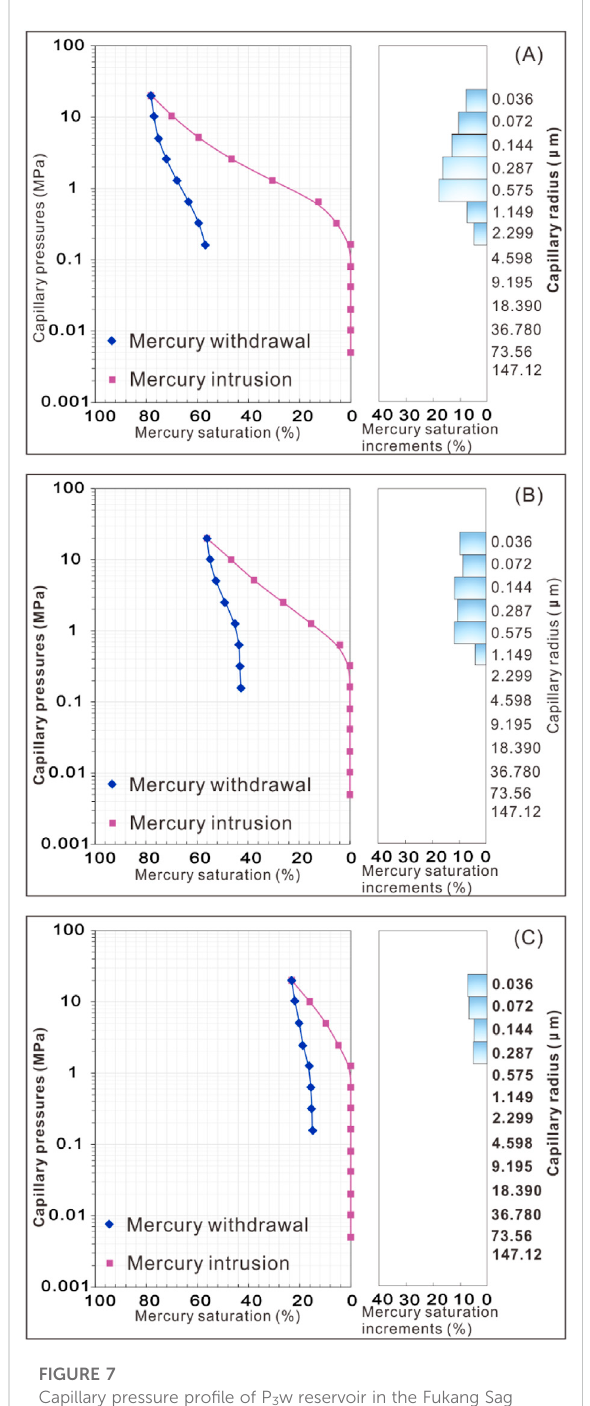
FIGURE 7 Capillary pressure pro fi le of P 3 w reservoir in the Fukang Sag (A) Medium-throated type, (B) Thin-throated type, and (C) extra- fi ne throat